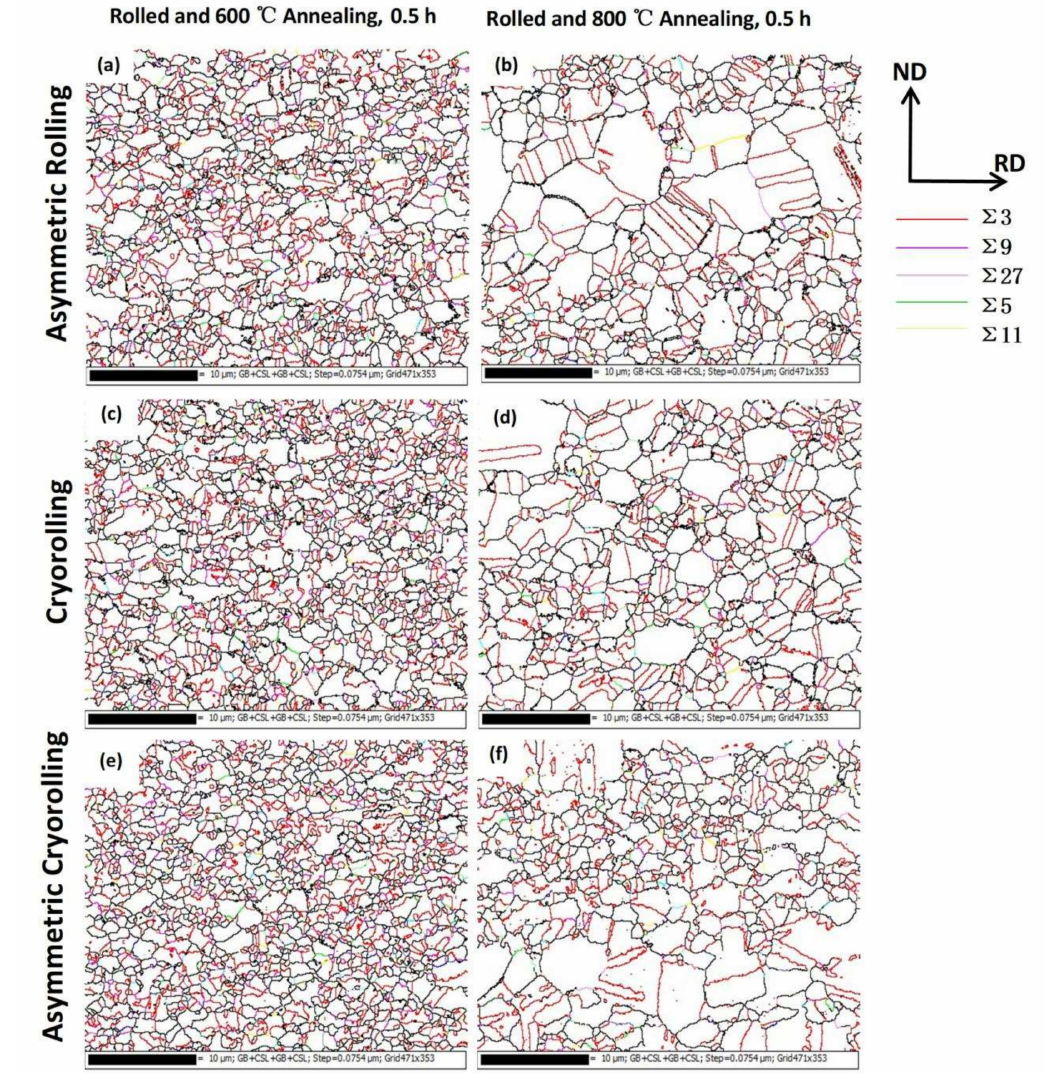
Figure 1. Coincidence site lattice (CSL) GB maps of ( a ) asymmetrically rolled medium entropy alloys (MEA) CrCoNi with annealing at 600 ◦ C, ( b ) asymmetrically rolled MEA CrCoNi with annealing at 800 ◦ C, ( c ) cryorolled MEA CrCoNi with annealing at 600 ◦ C, ( d ) cryorolled MEA CrCoNi with annealingat800 ◦ C,( e )asymmetriccryorolledMEACrCoNiwithannealingat600 ◦ C,and( f )asymmetric cryorolled MEA CrCoNi with annealing at 800 ◦